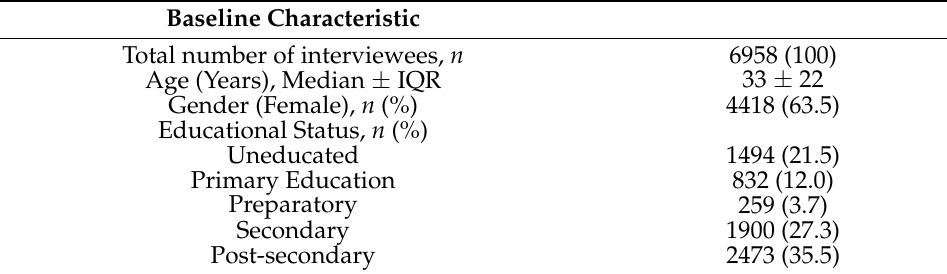
Table 1. Baseline Characteristics of the study